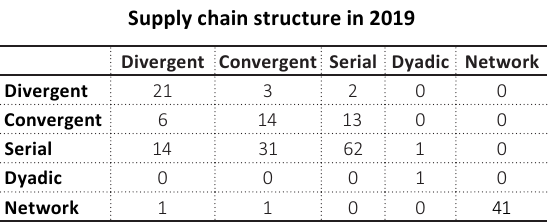
Table 2. Changes in the supply chain structure Supply chain structure in